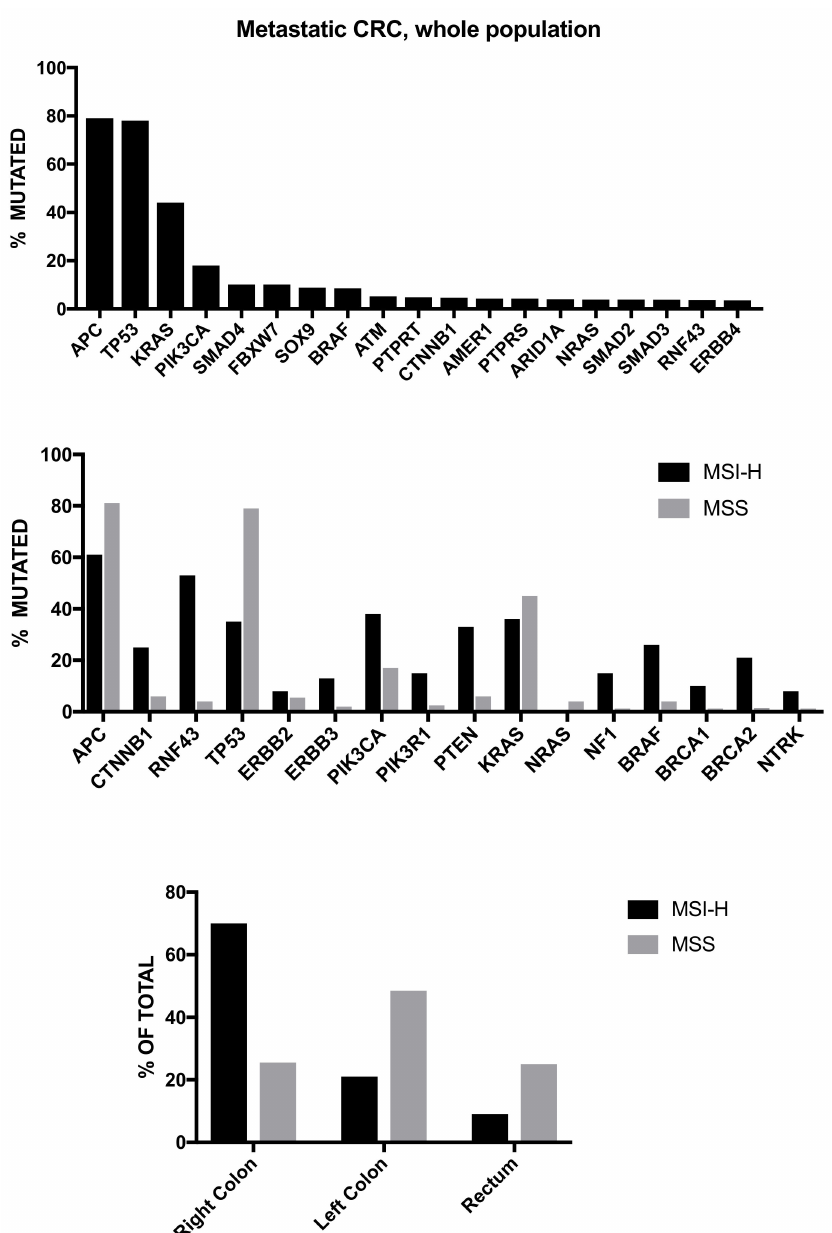
Figure 2. Frequency of the most recurrent genetic alterations observed in metastatic CRC patients (data reported by Yaeger et al., 2018) [24]. Top Panel: most recurrent genetic alterations observed in the whole population of metastatic CRC patients; Middle Panel: most recurrent genetic alterations observed in the population of metastatic CRC patients subdivided into MSI-H and MSS; Bottom Panel: tumor location in metastatic CRC patients exhibiting either MSI-H or